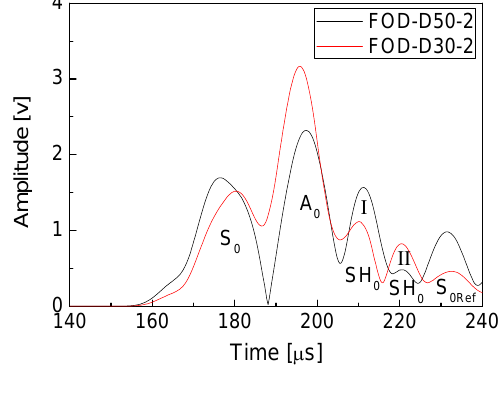
Figure 10. Envelopes of the filtered guided wave signals of CFRP laminates with double- 30 mm and double-50 mm delaminations.